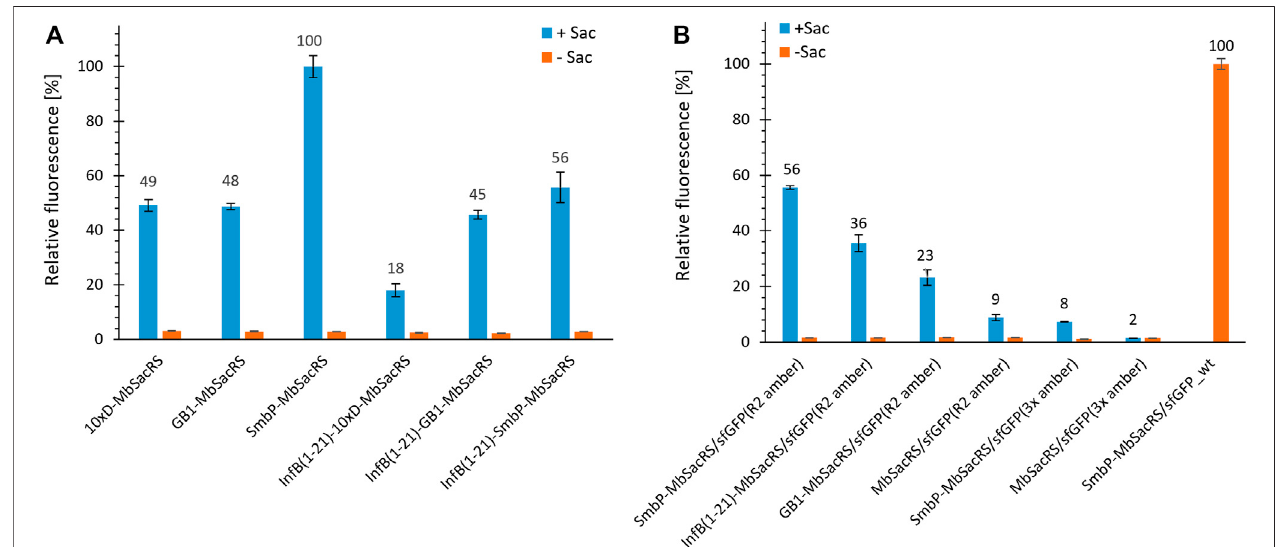
FIGURE 4 | Comparison of OTS ef fi ciency for Mb SacRS fusion constructs measured by the fl uorescence of intact E. coli BL21 (DE3) cells. (A) Best-performing solubility tags were tested alone and in combination. (B) Comparison of fusion constructs to the untagged starting enzyme. Reporter constructs for the suppression of one or three stop codons were sfGFP(R2 amber) and sfGFP(3x amber), respectively. Wild-type sfGFP without an in-frame stop codon was included as benchmark. Endpoint measurements in presence (+Sac (cid:1) 2 mM) or absence of ncAA supplementation ( − Sac).